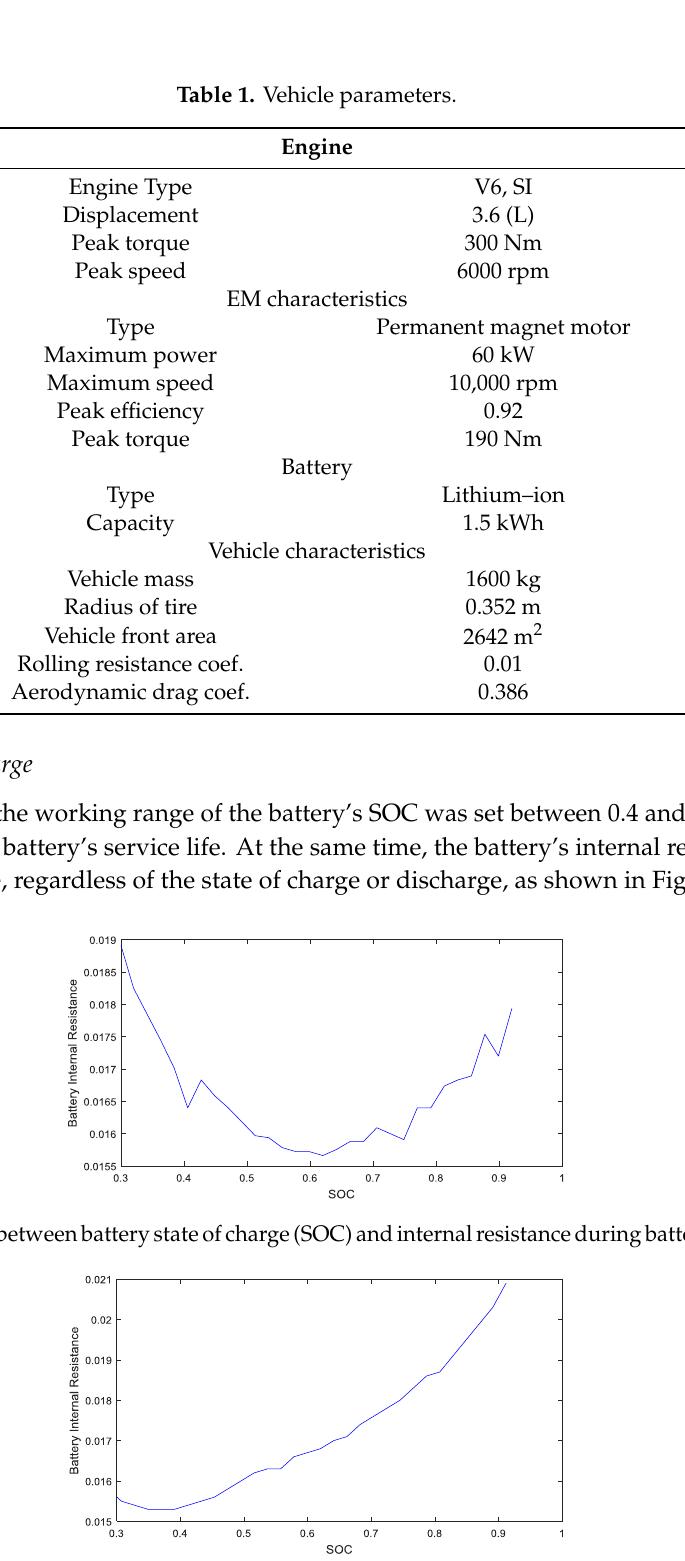
Table 1. Vehicle parameters.